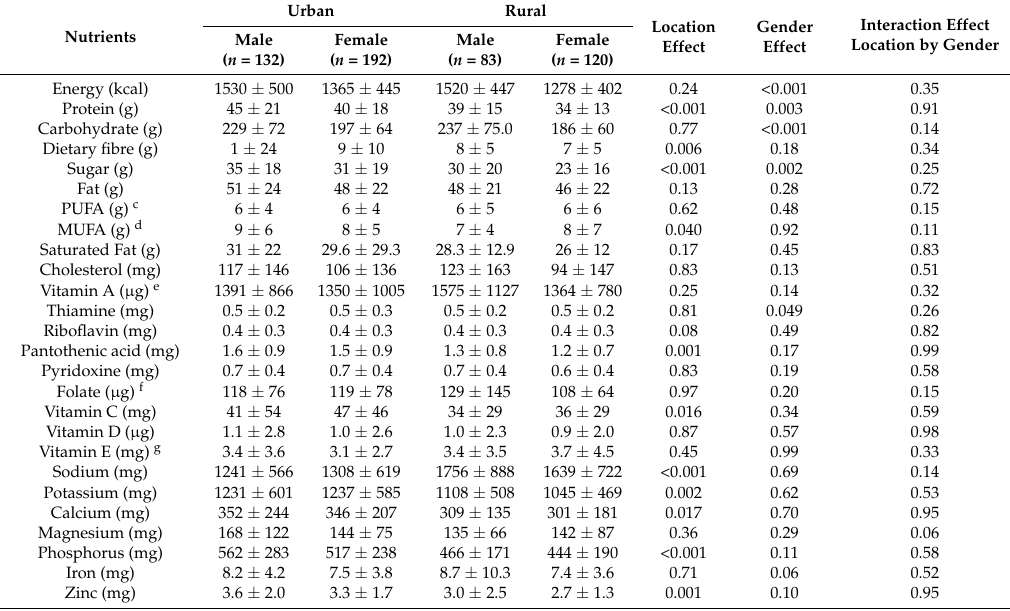
Table 3. 24-h recall nutrient intakes a,b